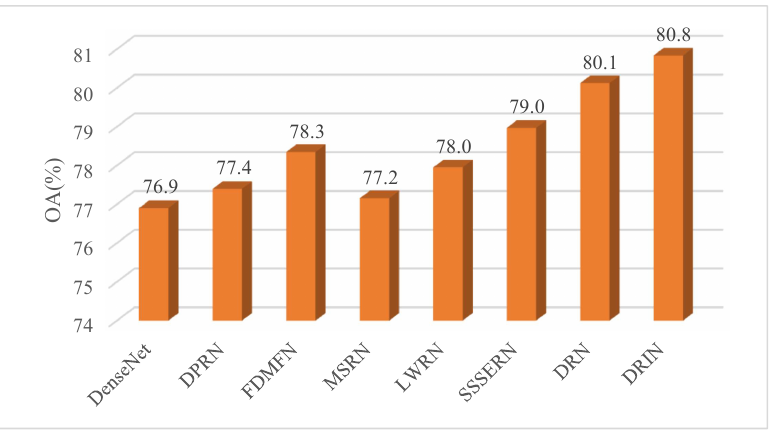
Figure 19. OA scores averaged across all four benchmarks. Table 17. The results of Wilcoxon’s tests over OA across all four benchmarks. We boldfaced the entries significant at p <